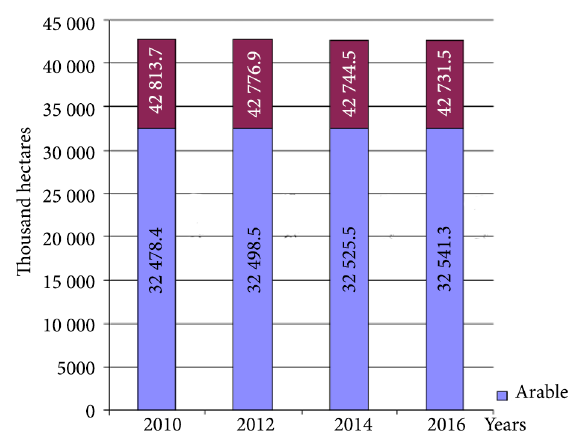
Figure 5. Dynamics of changes in the areas of